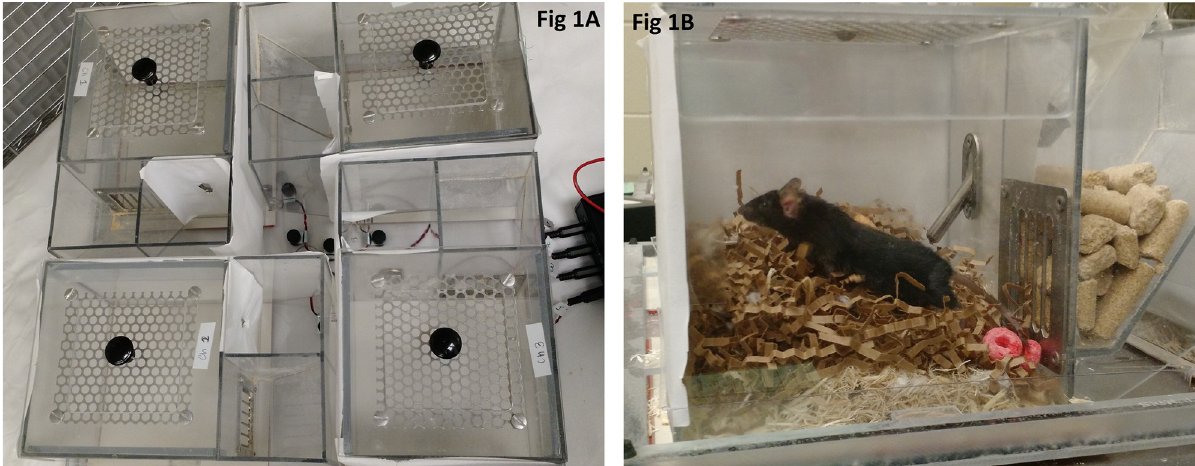
Fig 1. Sleep apparatus viewed from above (A) and a close up side view of an individual mouse cage (B). Sugary cereal used for the sucrose preference test can be seen in B.